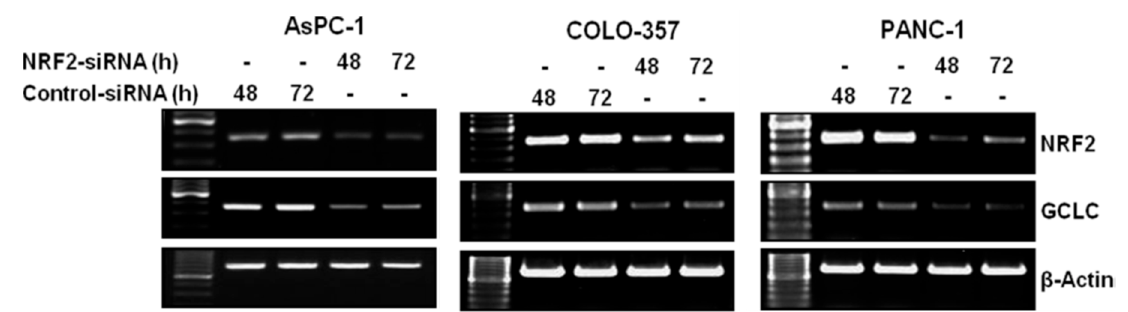
Figure 1. NRF2 knockdown inhibits the mRNA expression of NRF2 and GCLC. AsPC-1, COLO-357 and PANC-1 cells transfected with NRF2-siRNA or control-siRNA for 48 h or 72 h were subjected to RT-PCR analysis using primers specific for NRF2, GCLC and β -Actin. Western blot analysis also showed that the expression of NRF2 was significantly reduced in NRF2-siRNA transfected AsPC-1 and COLO-357 cells, compared to those in control cells (Figure 2).